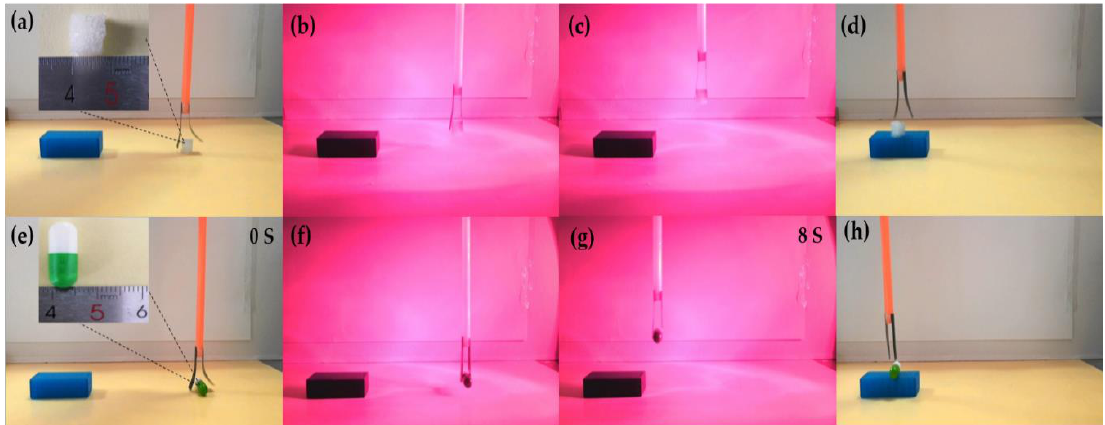
Figure 5. Optical-responsive flexible gripper. ( a – d ) Images showing a multilayered membrane-based gripper driven by infrared light to grab and transported foam cubes. ( e – h ) Gripper transfer medicinal capsules (0.06 g) in 11 s.